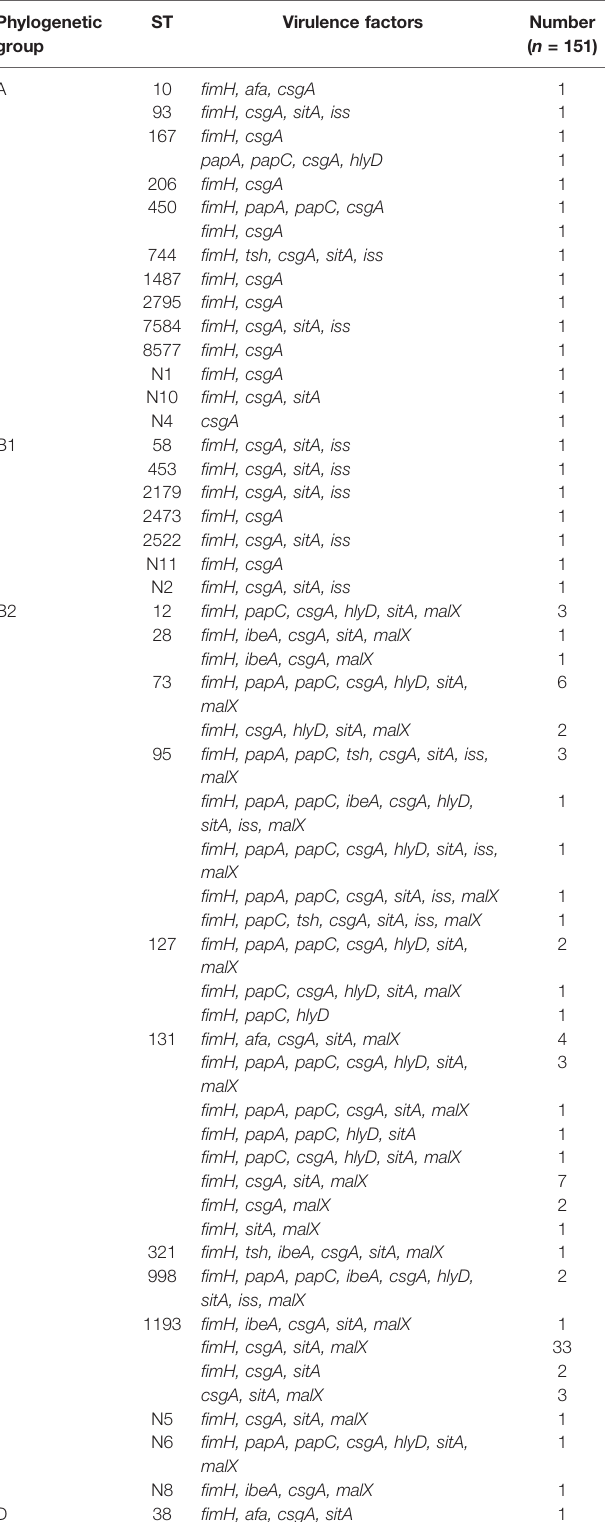
TABLE 3 | Distribution of virulence genes among UPEC isolated from female patients. Phylogenetic